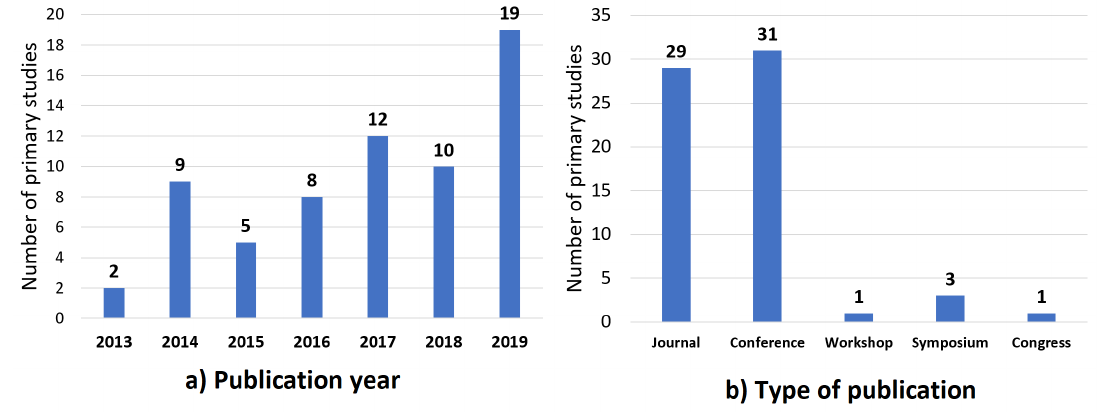
Figure 2. Number of the SPS published per ( a ) year and per ( b ) type of publication.